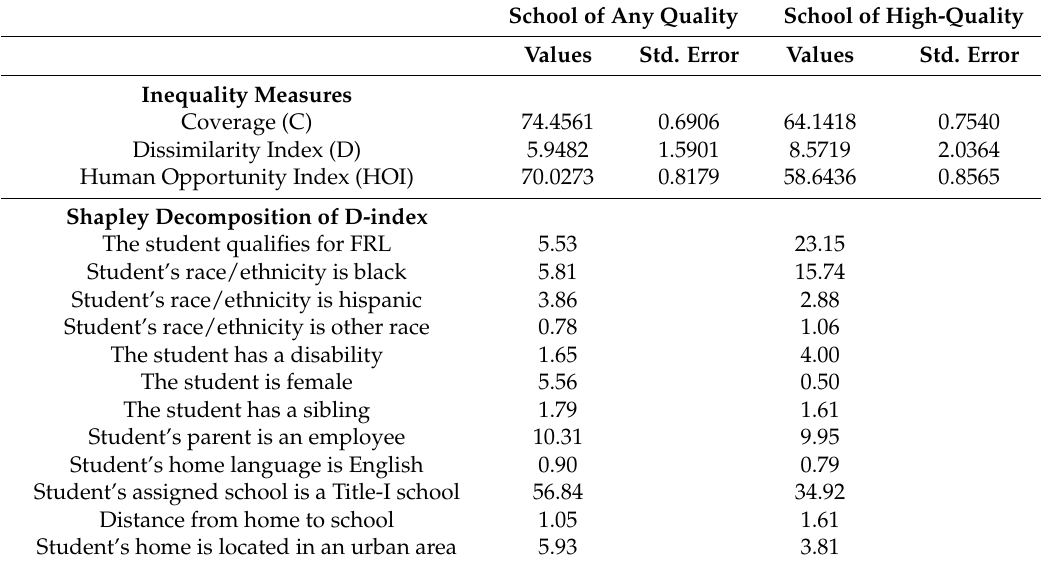
Table 6. Inequality Measures and contribution of circumstances to IOP for the opportunity of getting an offer to an SDHC magnet middle